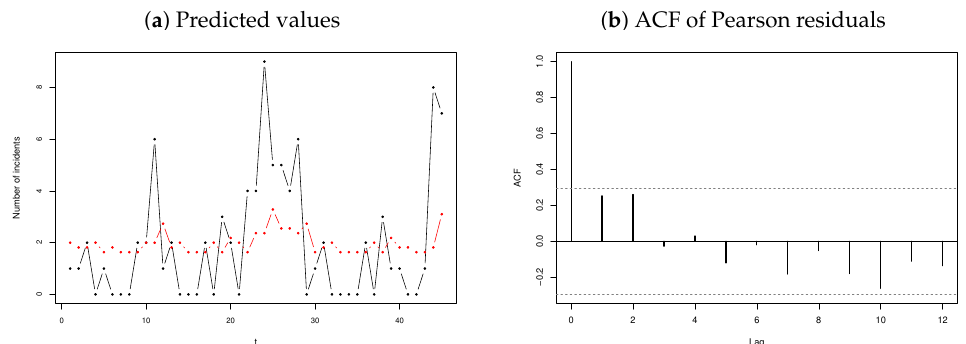
Figure 11. Predicted values (in red) and ACF of the Pearson residuals for the terrorism data.